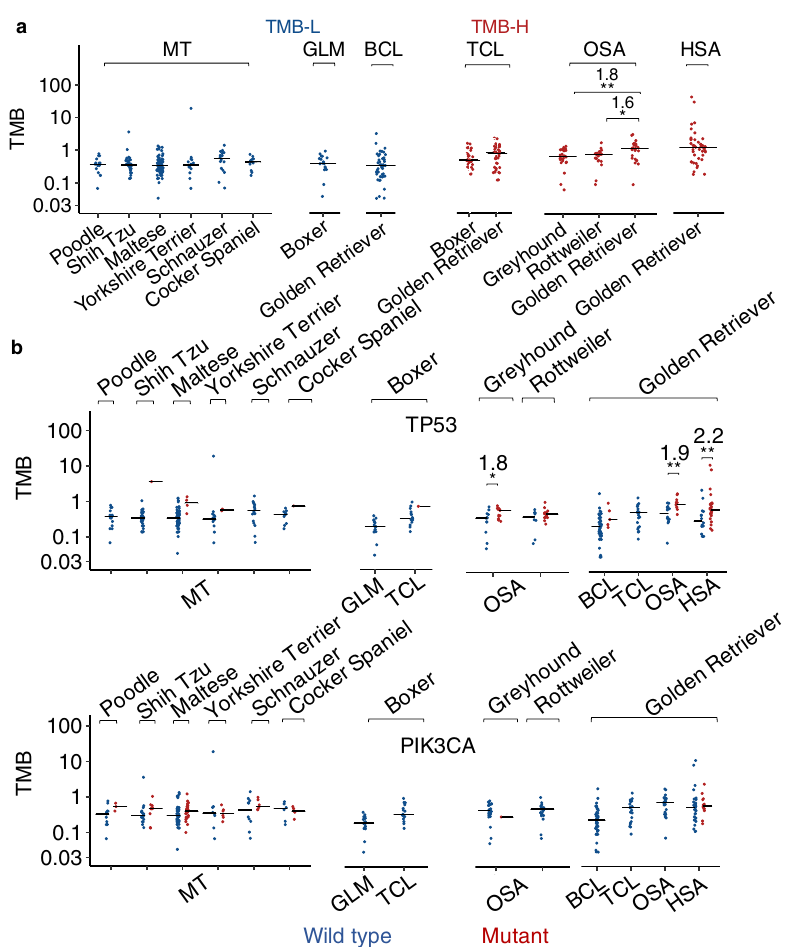
Fig. 7 TMB is largely independent of breeds. a TMB distributions of cases grouped by tumor type and then breed. Only groups with ≥ 10 tumors are shown, with n = 15, 28, 70, 14, 16, 11, 17, 44, 16, 21, 25, 21, 25 and 42 independent tumors from left to right. Two-sided Wilcoxon tests were conducted, with ** and * representing unadjusted p = 0.009 and 0.01, respectively, and fold-changes shown. b TMB distributions of tumors grouped by breed, tumor type, and fi nally TP53 (top) or PIK3CA (bottom) mutation status. Only groups with TP53 (or PIK3CA ) wild-type and mutant-combined tumors of ≥ 10 are shown, with n = 15, 27, 1, 66, 4, 12, 2, 16, 10, 1, 17, 15, 1, 12, 13, 8, 13, 39, 5, 21, 14, 11, 14 and 28 (top) and n = 12, 3, 18, 10, 41, 29, 8, 6, 10, 6, 6, 5, 17, 16, 24, 1, 21, 44, 21, 25, 29 and 13 (bottom) independent tumors left to the right. Two-sided Wilcoxon tests were conducted, with *, **, and ** from left to right representing unadjusted p = 0.04, 0.003, and 0.008, respectively, and fold-changes shown. Source data are provided as a Source Data fi